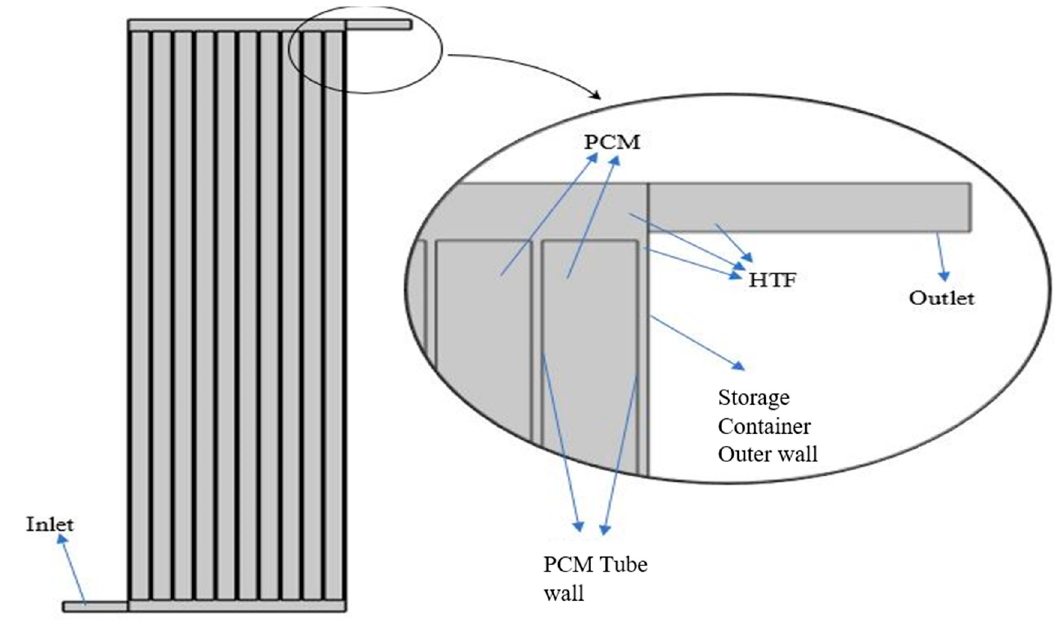
Figure 1. Energy storage tank modeling in COMSOL.